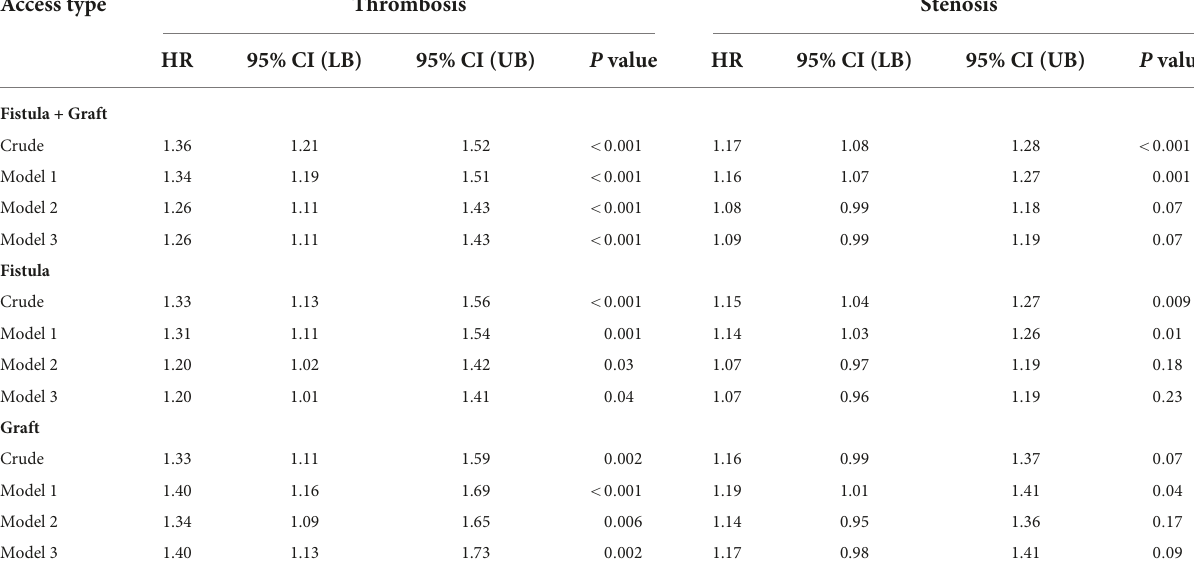
TABLE 4 Multivariate Cox regression analysis of the association between BPV and outcomes of vascular access, displayed by the whole cohort and stratified by access types. Access type Thrombosis Stenosis